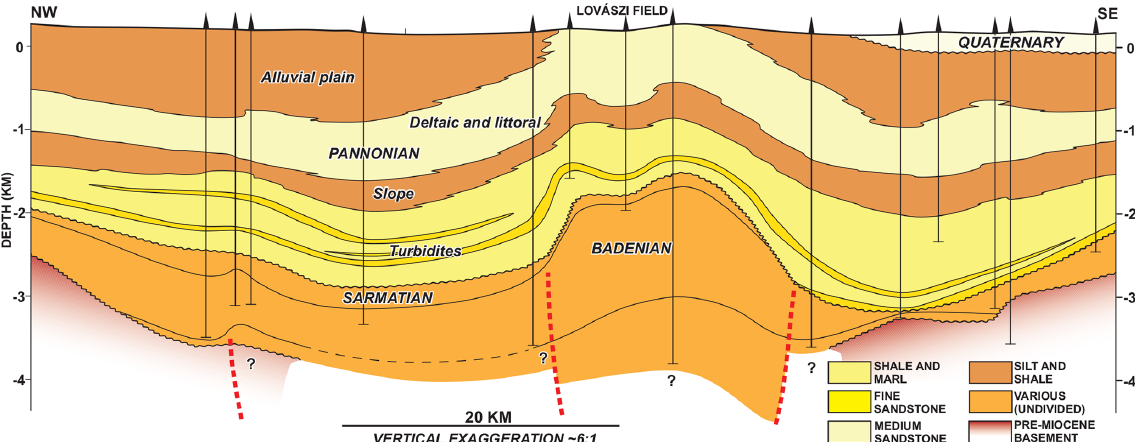
Figure 6. This subregional lithostratigraphic transect, crossing the Lovászi field, was redrafted after Juhász (1994, 1998). Her study was not devoted to the structural evolution of the area but rather to the correlation of various lithologies of the Miocene and Pliocene sequence primarily using well data. Note the missing Pannonian sequence above the Lovászi anticline, which could have an 800–1000m thickness. Given the slightly asymmetric shape of the Lovászi anticline, we inferred the presence of a master syn-rift fault and added it to the original illustration (dashed red line) beneath its southern flank (cf. Fig.